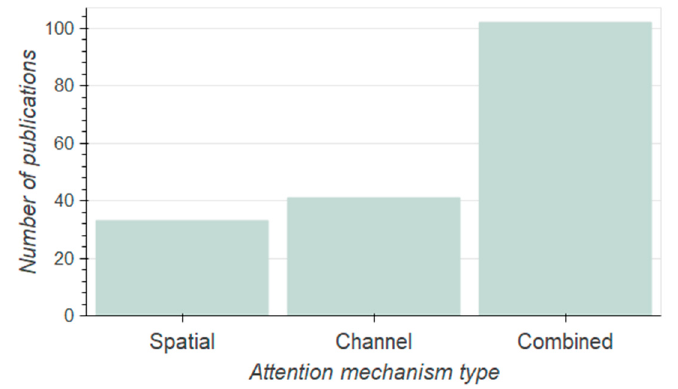
Figure 10. The attention mechanism type used in the papers.